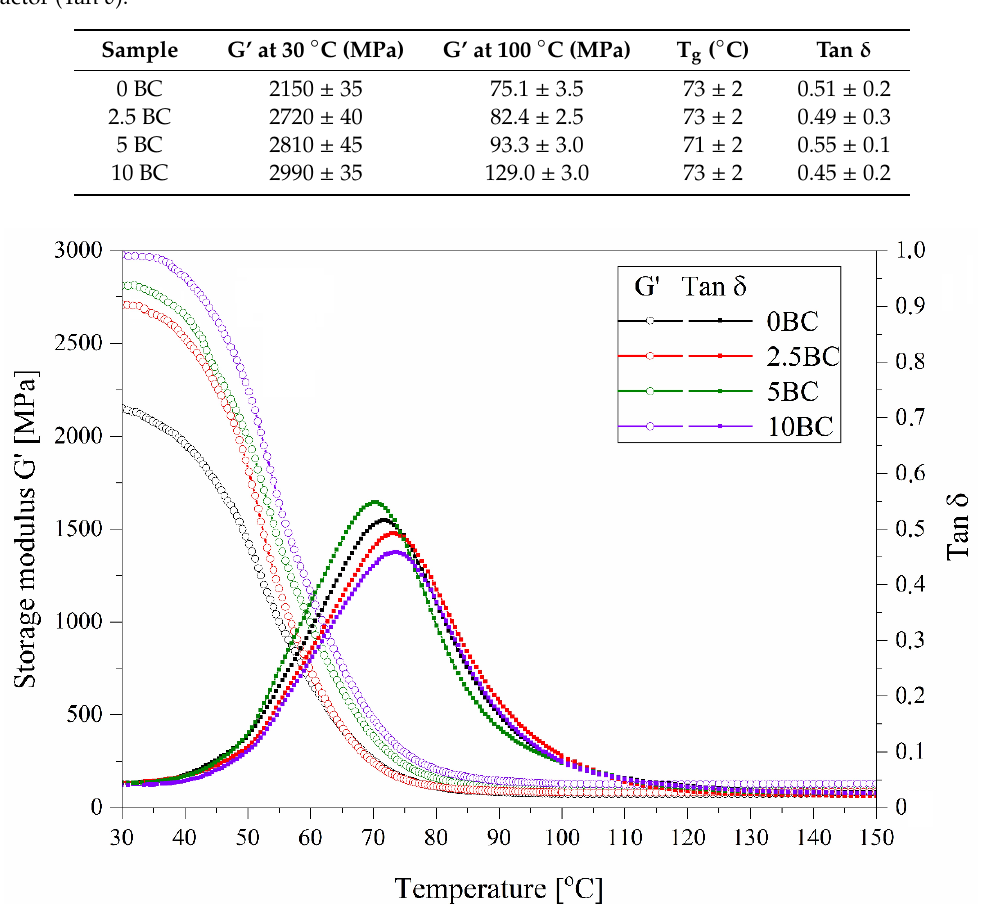
Table 1. DMTA analysis data: storage modulus (G’), glass transition temperature (T g ) and damping factor (Tan δ ).